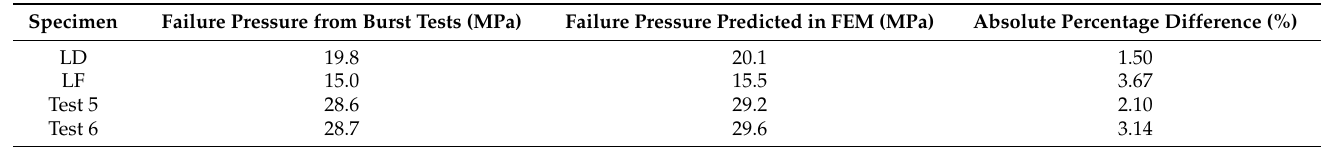
Table 4. Validation of FEM results against burst test for pipes only subjected to internal pressure and combined loadings of internal pressure and longitudinal compressive